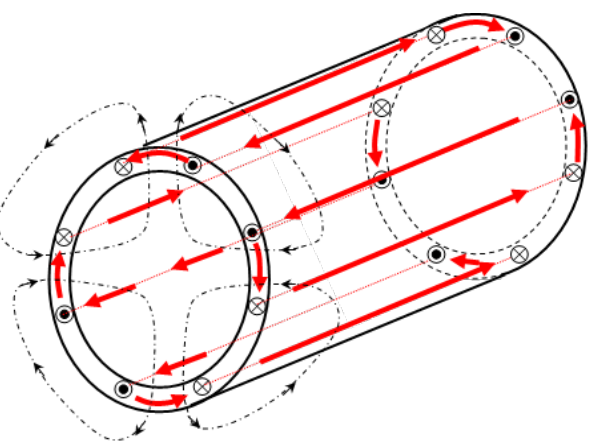
Figure 2. Eddy currents in the stator